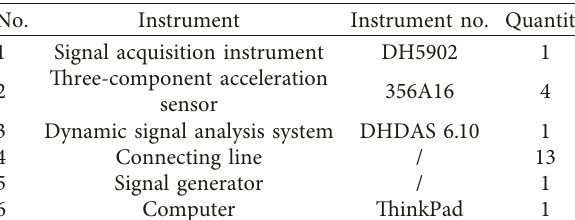
Table 3: List of the modal test equipment